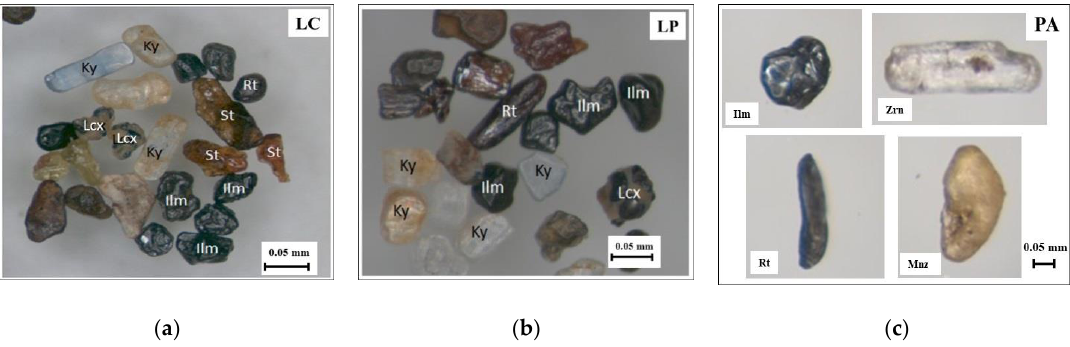
Figure 5. Examples of some heavy minerals identified via optical microscopy of LC ( a ), LP ( b ) and PA ( c ) samples. Note: Ilm: ilmenite, Ky: kyanite, Lcx: leucoxene, Mnz: monazite, Rt: rutile, St: staurolite and Zrn: zircon.